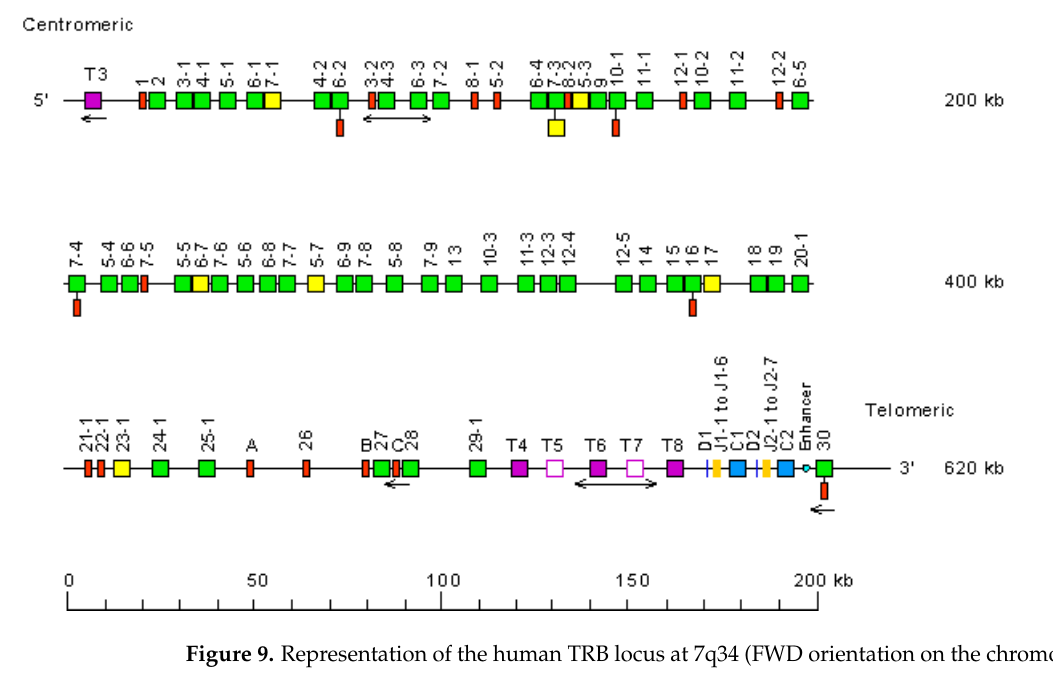
Figure 9. Representation of the human TRB locus at 7q34 (FWD orientation on the chromosome). The boxes representing the genes are not to scale. Exons are not shown. The TRBV genes are designated by a number for the subgroup followed, whenever there are several genes belonging to the same subgroup, by a hyphen and a number for their relative localization in the locus. Numbers increase from 5 ′ to 3 ′ in the locus. T3 to T8 indicate trypsinogen or trypsinogen ‐ like genes. T3 (PRSS3P3, TRY3) is at 7.4 kb upstream of TRBV1. Single arrows show genes whose polarity is opposite to that of the D ‐ J ‐ C ‐ CLUSTER. Double arrows indicate insertion/deletion polymorphisms. IMGT ® http://www.imgt.org (accessed on 20 February 2022), IMGT Repertoire (IG and TR) 1. Locus Lefranc, LIGM, Founders and Authors of IMGT ® , the international ImMunoGeneTics information system ® , http://www.imgt.org) (accessed on 20 February 2022).